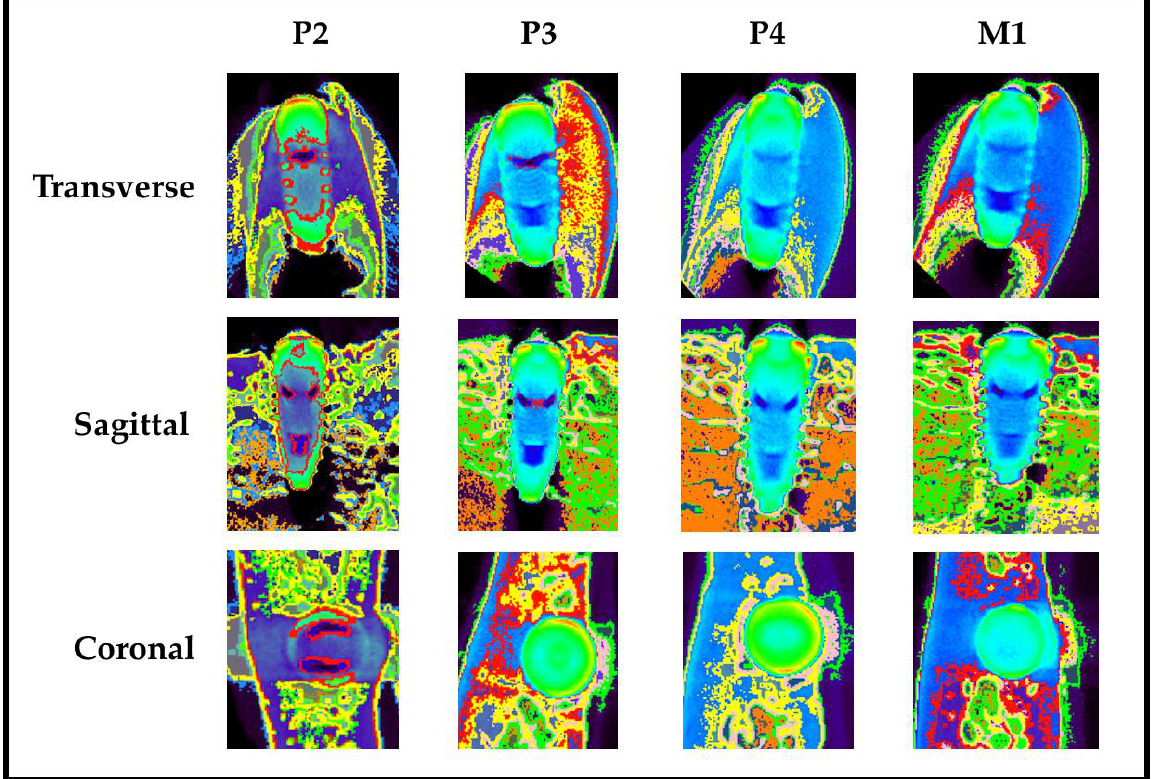
Figure 3. Example of coded BD values from the AMIDE program at 12 weeks after implant placement in transverse, sagittal, and coronal sections of P2, P3, P4, and M1: 250–400 HU (orange color); 400–500 HU (green color); 500–700 HU (pink color); 700–900 HU (yellow color); 900–1200 HU (red color). >850 HU, bone type 1; 500–850 HU, bone type 2/3; 0–500 HU, bone type 4 (according to Norton and Gamble [36]).